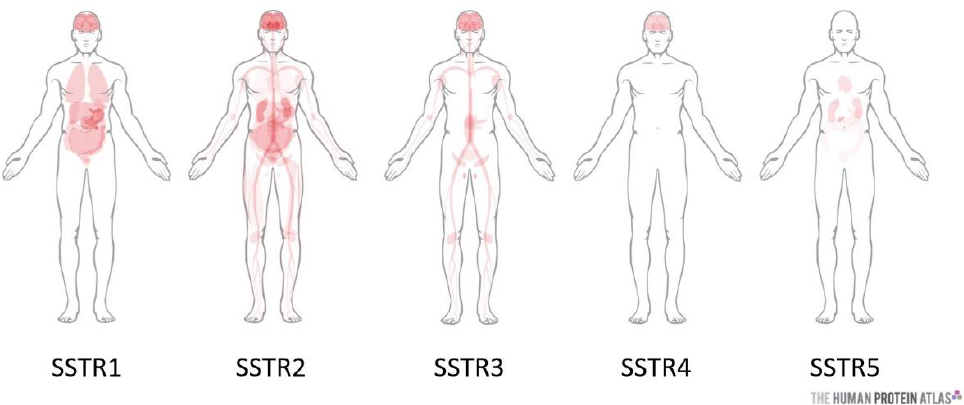
Figure 1. Somatostatin receptors (SSTRs) biodistribution in the body (from The Human Protein Atlas https://www.proteinatlas.org/).